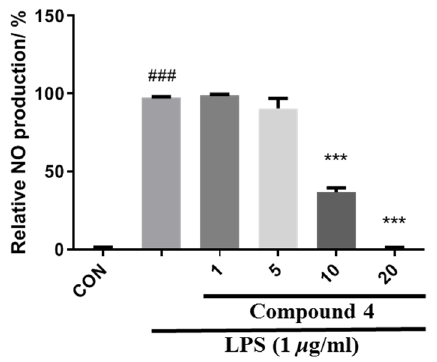
Figure 6. Effects of compound 4 isolated from B. exigua on NO production in LPS-stimulated RAW 264.7 macrophages. Cells were pretreated with the indicated concentrations of the isolates for 1 h and then stimulated with LPS (1 μg/mL) for 24 h. The NO levels in the culture medium were meas- ured by the MTT assay. ### p < 0.0001 vs. control. *** p < 0.0001 vs. LPS-stimulated group.